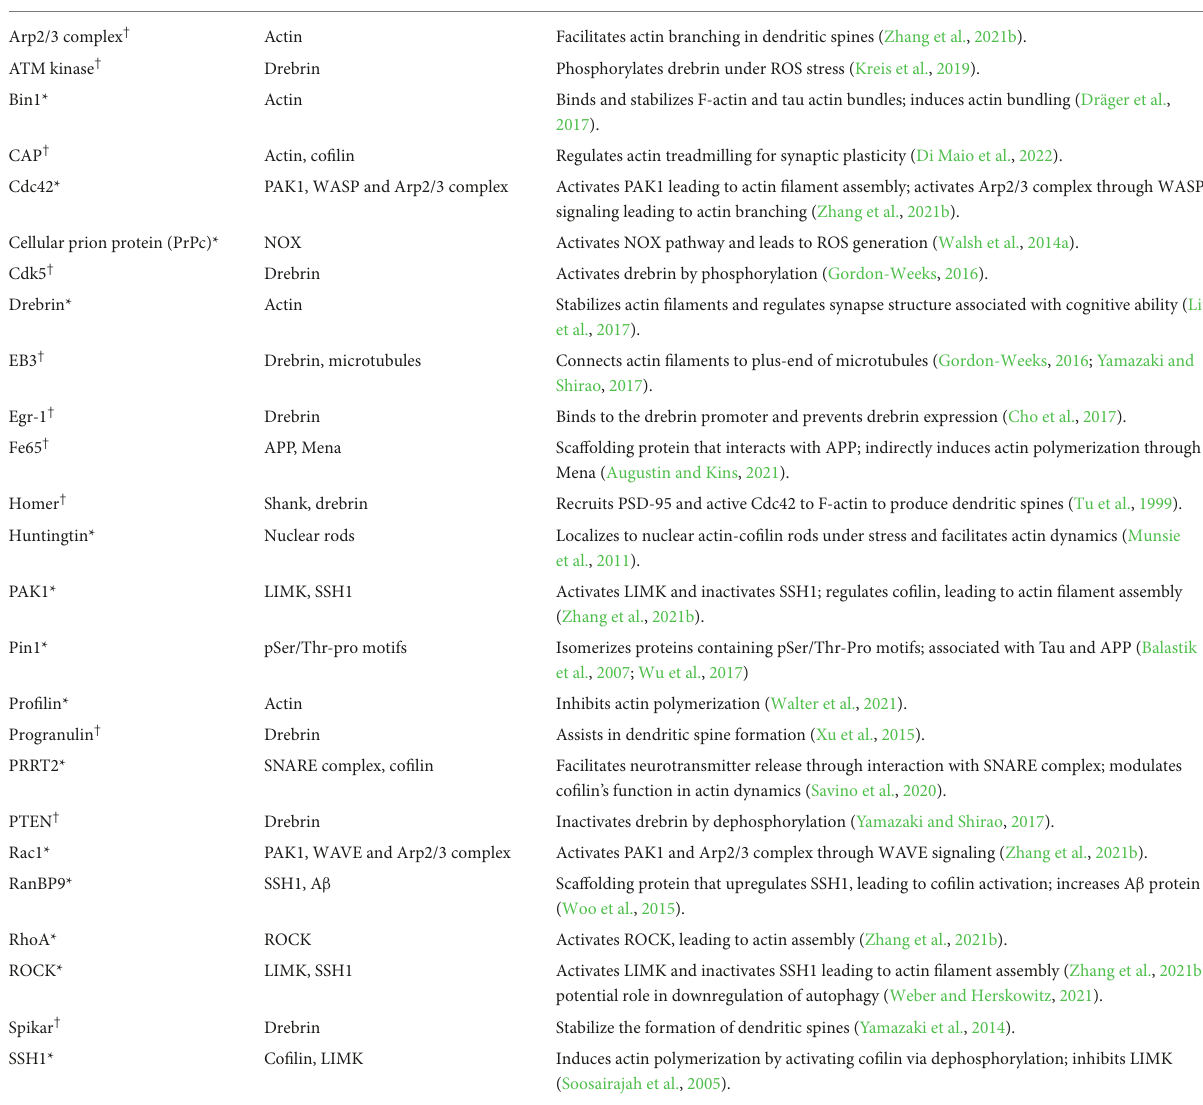
TABLE 2 Actin-binding and actin-associated proteins involved in cofilin-actin rod